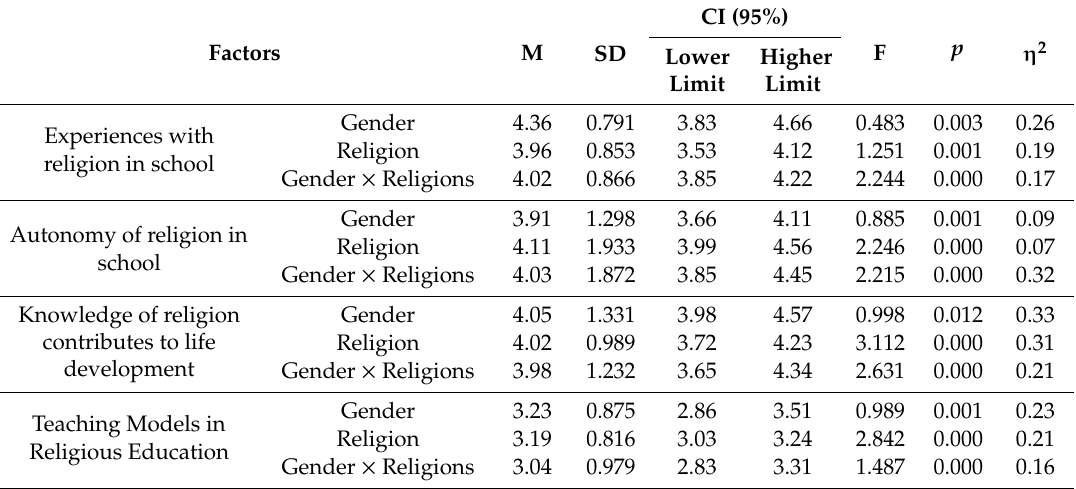
Table 2. Sums of aggregated scales (ANOVA and e ff ect size ( η 2)) for Religion in school by gender and